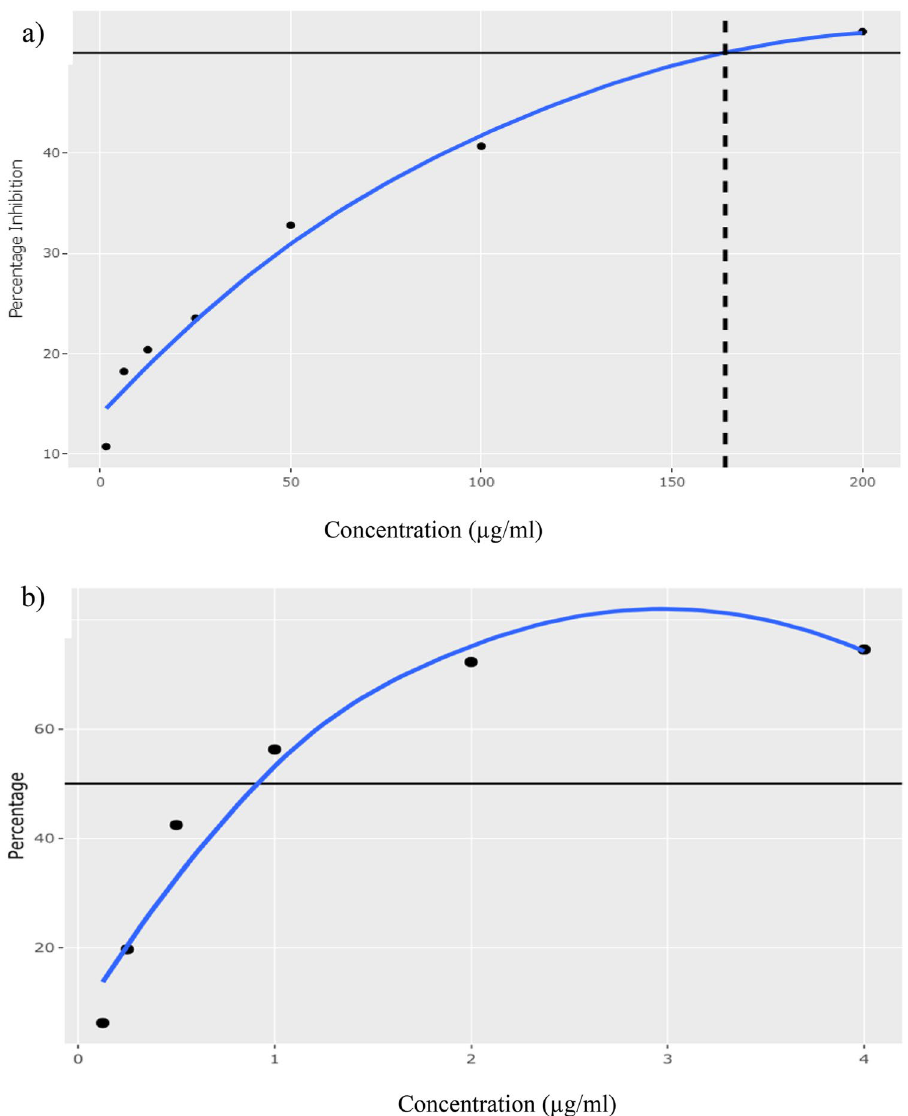
Figure 3. Percentage inhibition exhibited by ( a ) crude polyphenolic extract and ( b ) ascorbic acid against DPPH radical